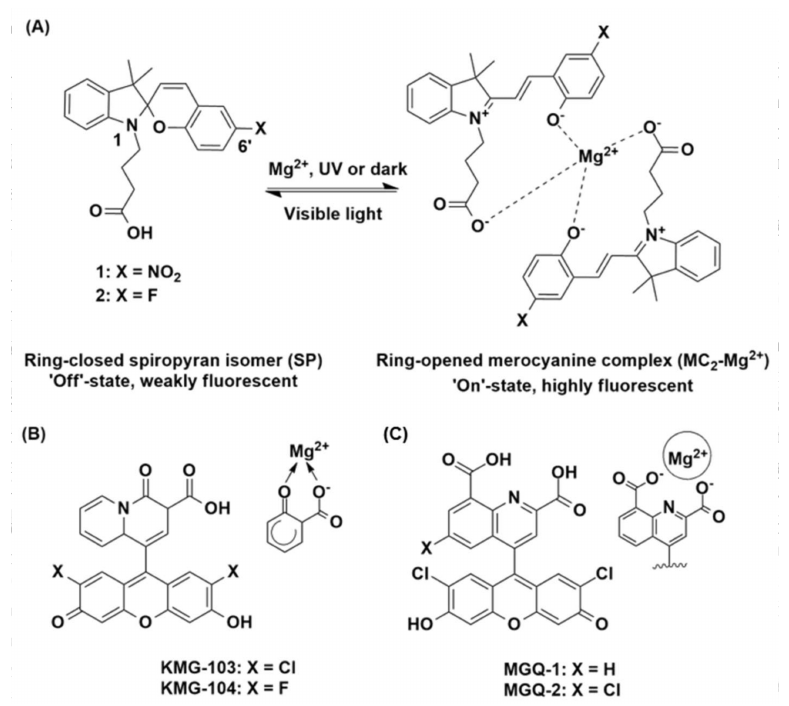
Figure 1. ( A ) Structures of 1 and 2 as the ring-closed, weakly fluorescent spiropyran (SP, ‘off’) isomer, and the proposed ring-opened, highly fluorescent merocyanine (MC 2 -Mg 2+ , ‘on’) complex. Structures of the ( B ) KMG [29] and ( C ) MGQ [30] chemosensors with the proposed Mg 2+ -binding domains